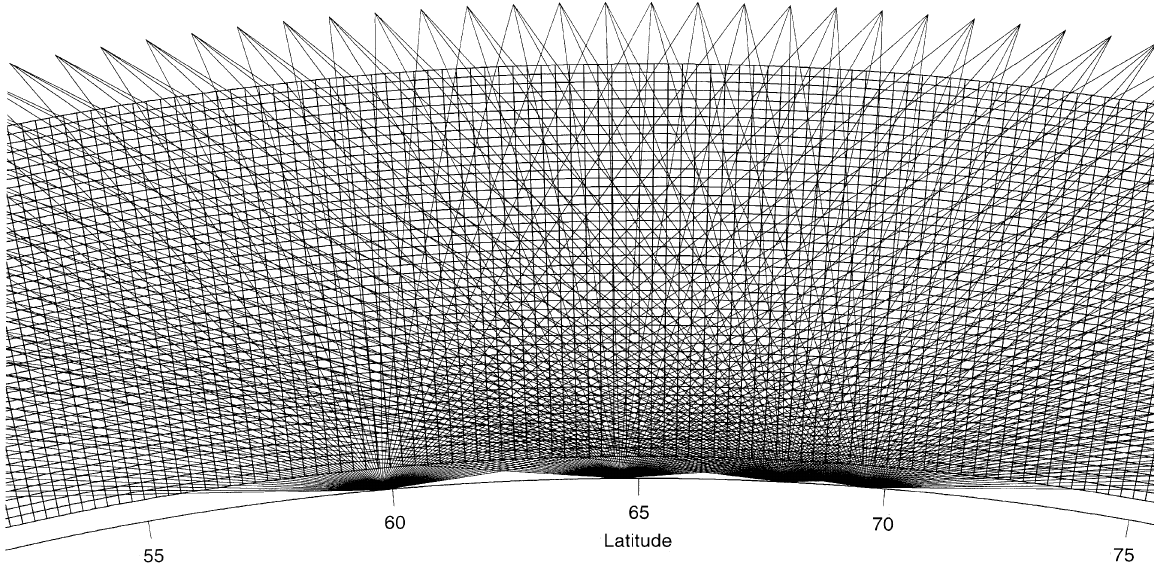
Fig. 1. Diagram showing typical satellite-to-receiver ray paths for an ionospheric tomography experiment